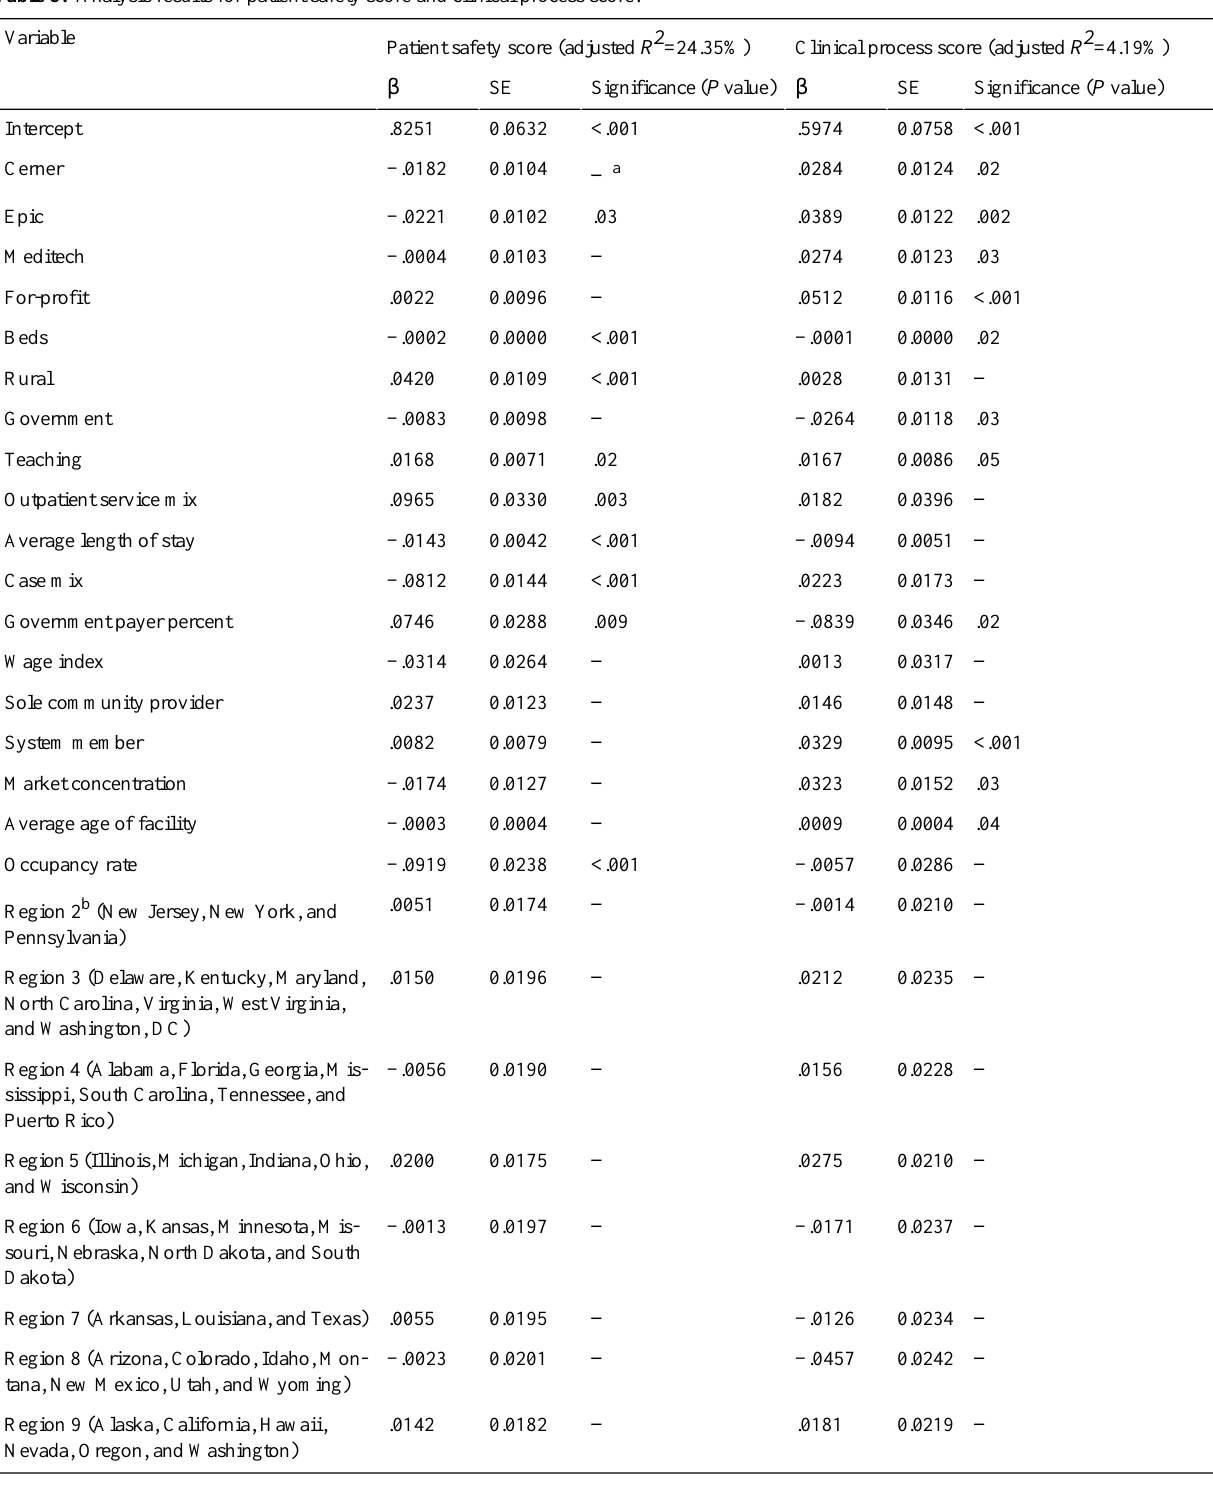
Table 5. Analysis results for patient safety score and clinical process